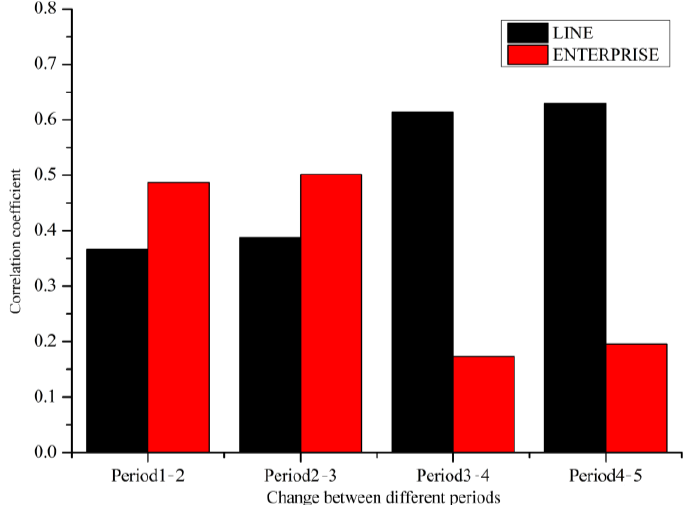
Figure 14. Histogram plot of the correlation between the change of predictors and the change of fire density .